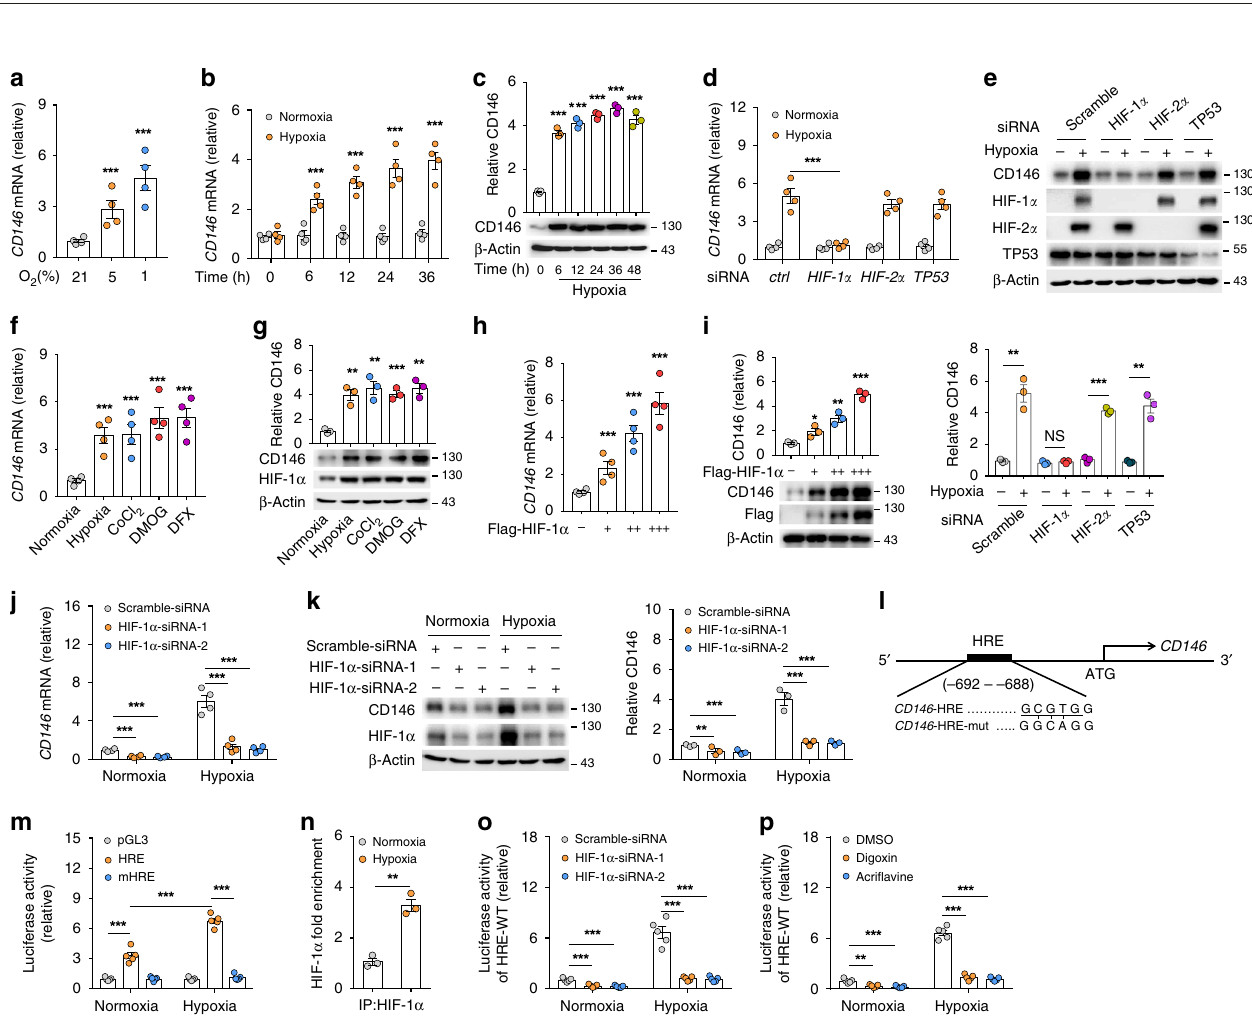
Fig. 1 CD146 elevation in PASMCs correlates with PH severity. a , b CD146 mRNA a or protein b expression in lungs with hypoxia-induced PH in mice and with MCT-induced PH in rats. Below in b , relative CD146 expression. c , d CD146 mRNA c or protein d expression in the lungs of mice during development of hypoxia-induced PH or of rats during development of MCT-induced PH. Below in d , relative CD146 expression. n = 3 b , d or n = 10 a , c lungs for each group. e , f Pearson comparison analyses showing the correlation between Cd146 mRNA levels (normalized to β -actin) in lung tissues and RVSP of mice during development of hypoxia-induced PH e or of rats during development of MCT-induced PH f ( n = 10 animals for each time point). g , h Top, mice were exposed to hypoxia for 4 weeks. The expression of CD146 in PAs and non-PAs fractions g or in isolated PAECs and PASMCs h was detected by western blotting (WB). Bottom, quanti fi cation of CD146 expression ( n = 3 independent experiments). i – k Representative immuno fl uorescence of CD146 (red) and α SMA (green) i or CD31 (green) k in small pulmonary arteries from mouse, rat and human lungs without or with PH. Nuclei are counterstained with DAPI (blue). Scale bars, 50 μ m. The images are representative of nine arteries per group. j Quanti fi cation of the mean fl uorescent intensity (MFI) of CD146 ( n = 9 arteries per group). l Quanti fi cation of the colocalization of CD146 and α SMA signal or CD146 and CD31 signal in i and k . m , n Bottom, CD146 protein expression in PASMCs isolated from mice during development of hypoxia-induced PH m or from rats during development of MCT-induced PH n . Top, relative CD146 expression ( n = 3 independent experiments). In all statistical plots, the results are expressed as mean ± s.e.m. P < 0.05, ** P < 0.01, *** P < 0.001. One-way ANOVA with Bonferroni post hoc analysis a – c or two-tailed Student ’ s t test d , g , h , j , l , m , n . All WB represent data from three b , d , g , h , m , n independent experiments. Source data are provided as a Source Data fi le